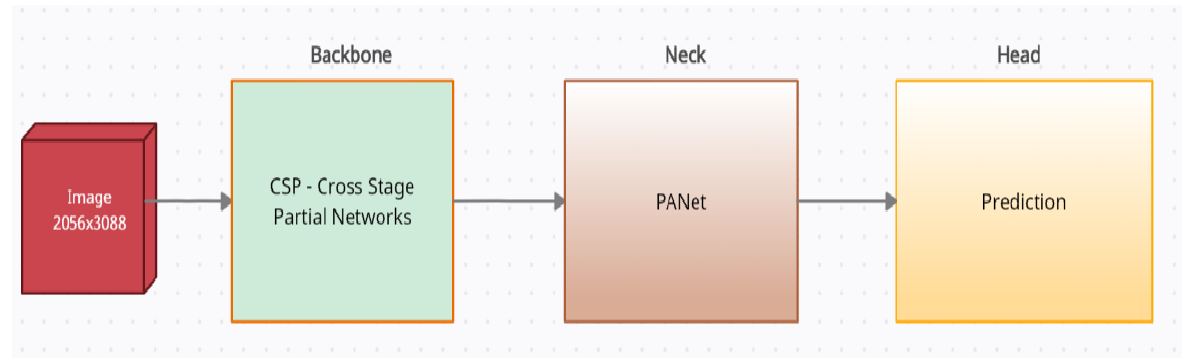
Figure 7. Architecture YOLOv5.